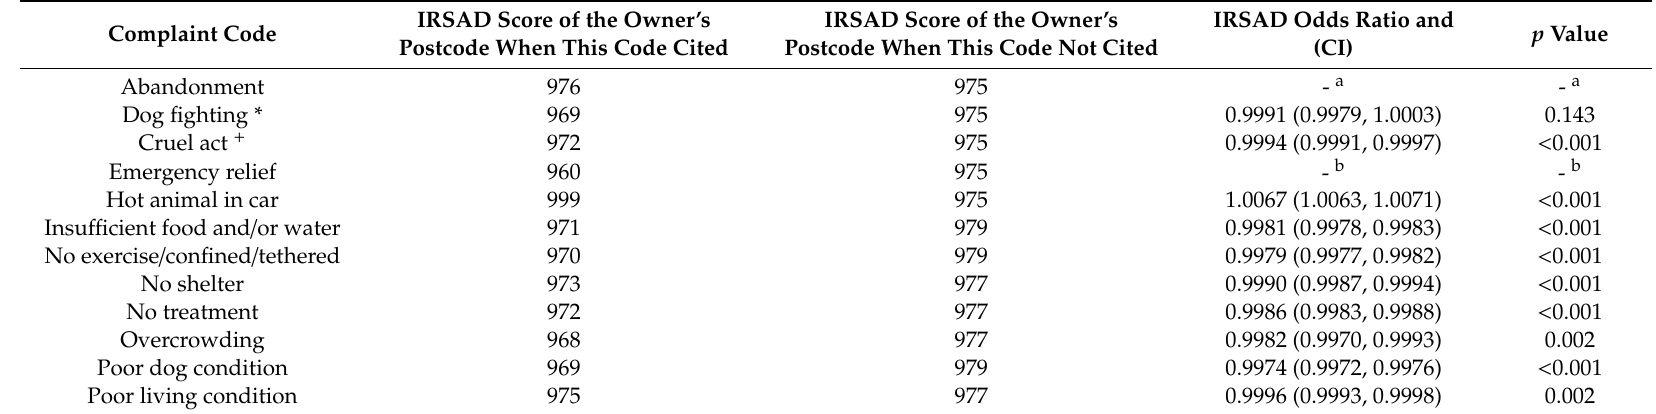
Table 4. Median Index of Relative Socio-Economic Advantage and Disadvantage (IRSAD) scores of the postcode of reported dogs for whom each complaint code was used, and the odds ratio and the 95% confidence interval (CI) of the IRSAD score in the logistic regression model of complaint codes. Outcomes of these models were di ff erent complaint codes and the fixed factor was the IRSAD score of the owners’